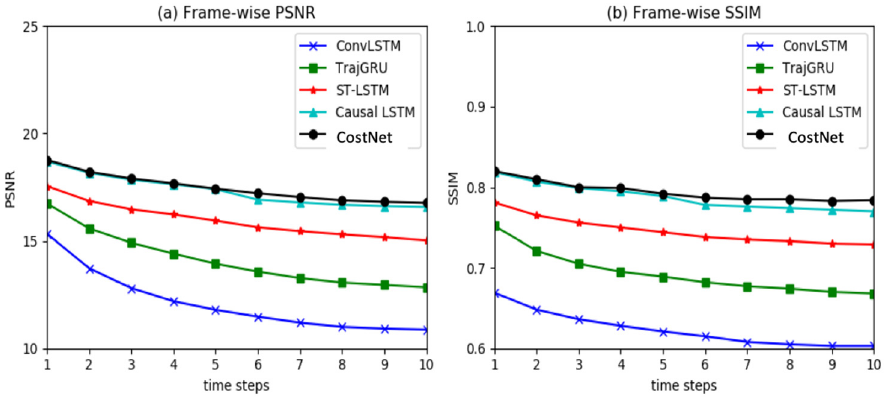
Figure 5. Frame-wise comparisons of di ff erent models for predicting 10 frames on the radar dataset.